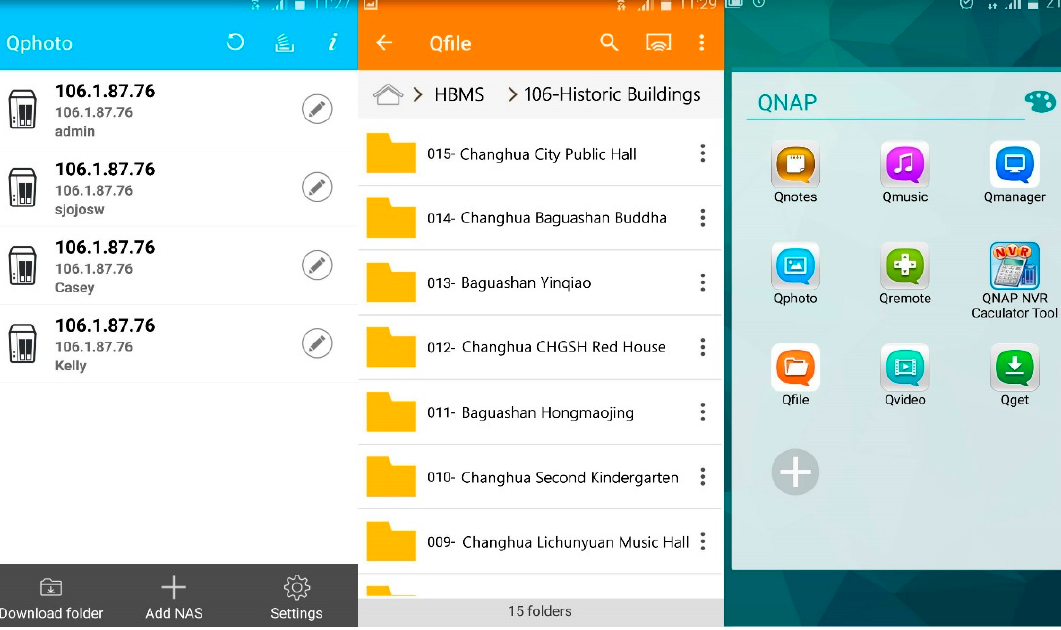
Figure 4. Software management interface on a mobile device. Arts 2018 , 7 , x FOR PEER REVIEW